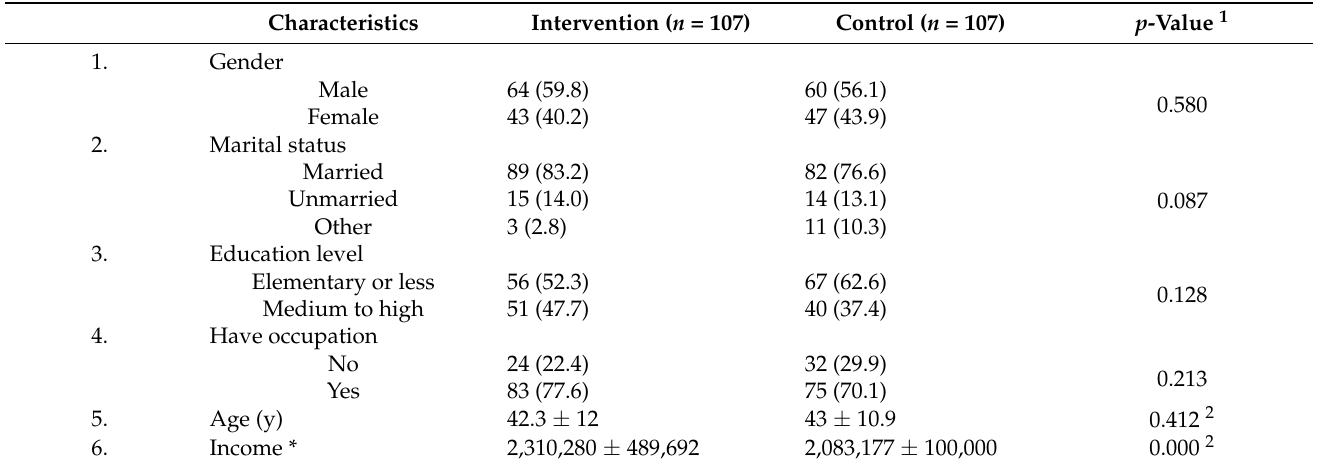
Table 1. Between-group comparison of participants’ demographic characteristics.